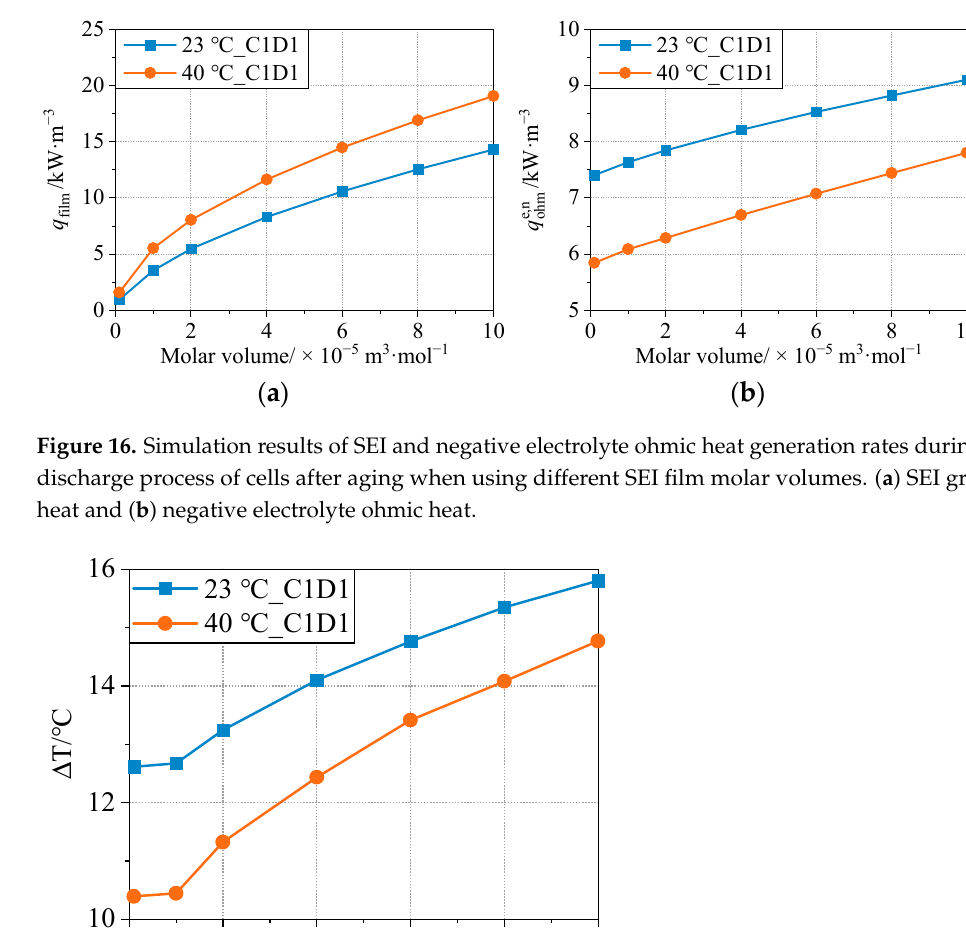
Figure 15. Simulation results of SEI film resistance and anode porosity of cells after aging when using different SEI film molar volumes.